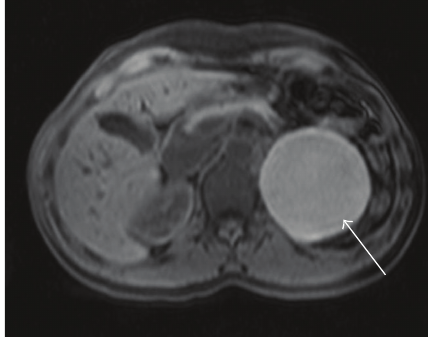
Figure 2: Fat suppressed T1-weighted turbo spin echo transverse image reveals high intensity in the lesion (arrow), excluding the presence of fat.